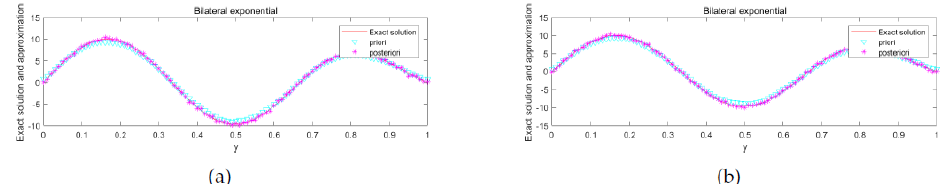
Figure 12. ( a ) δ = 1 × 10 − 1 . ( b ) δ = 1 × 10 − 2 . The exact solution and the regularized solution of f ( x ) when α = 1.8.